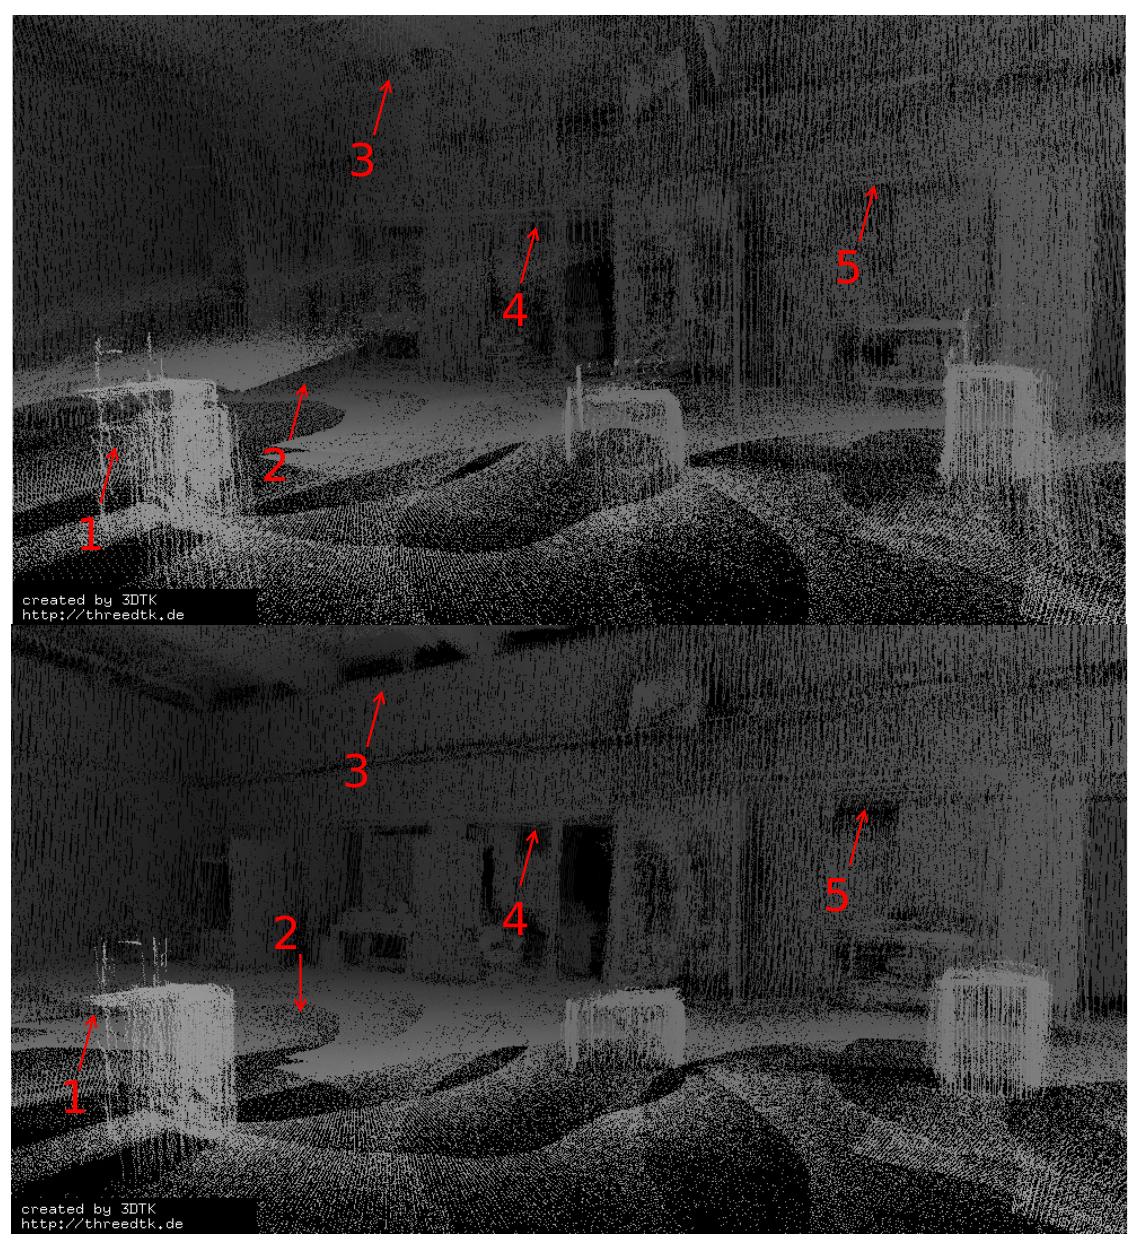
Figure 7. 3D point cloud of Experiment 1 without reflectance values. The color denotes the height. The boxes (1) and the rotated floor (2) converge, the windows at the ceiling (3) become visible. However, the office doors (4 and 5) remain